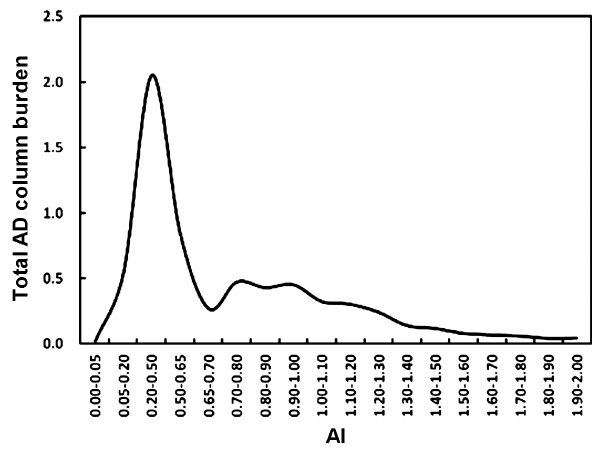
Figure 2. Total global anthropogenic dust (AD) column burden (Tg) as a function of the climatological mean aridity index (AI).